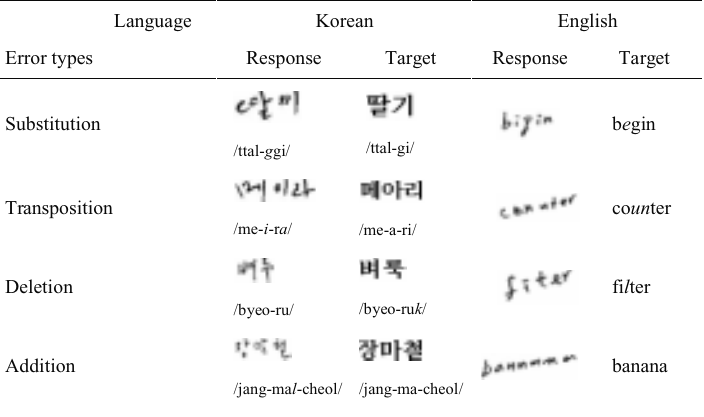
Table 3 Examples of error types in Korean and English writings